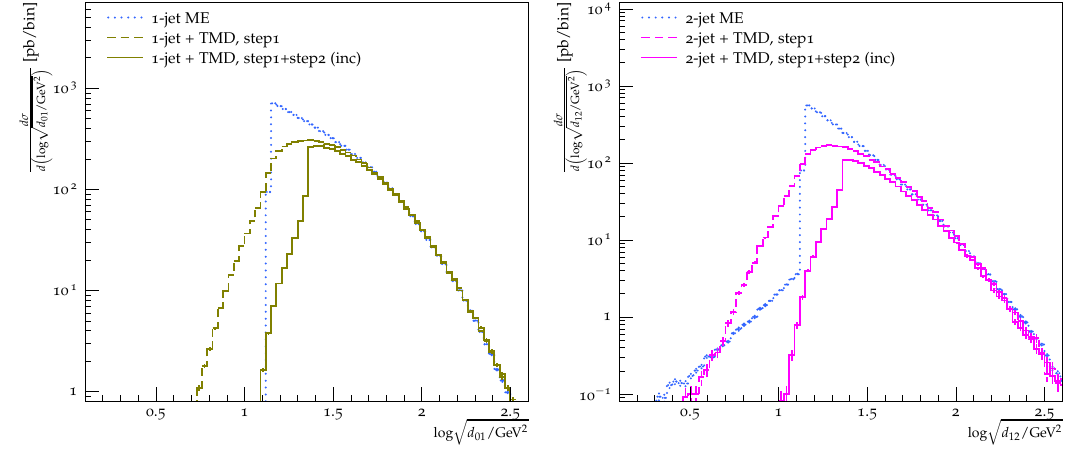
Figure 6 . The d n,n +1 spectra for n = 0 (left) and n = 1 (right) at parton level, where d n,n +1 represents the energy-square scale at which an ( n + 1) -jet event is resolved as an n -jet event in the k jet-clustering algorithm. The dotted blue curves represents the ME level of the Z + 1 (left) ⊥ and Z + 2 (right) jet calculations. The dashed green and magenta curves represent the Z + 1 and Z + 2 jet computations respectively after step1 of the TMD merging method is applied where step1 corresponds to the items 1, 2, 3 and 4 of the procedure. The solid green and magenta curves represent the Z + 1 and Z + 2 jet computations respectively when the full TMD merging method is applied (step1 + step2, where step1 corresponds to the items 1, 2, 3 and 4 of the procedure while step2 corresponds to item 5). The predictions represented by the solid lines are calculated in inclusive (inc)